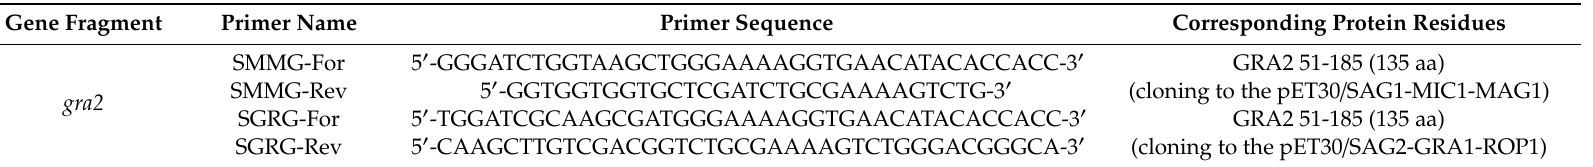
Table 1. Oligonucleotide primers used for the amplification of gra2 gene